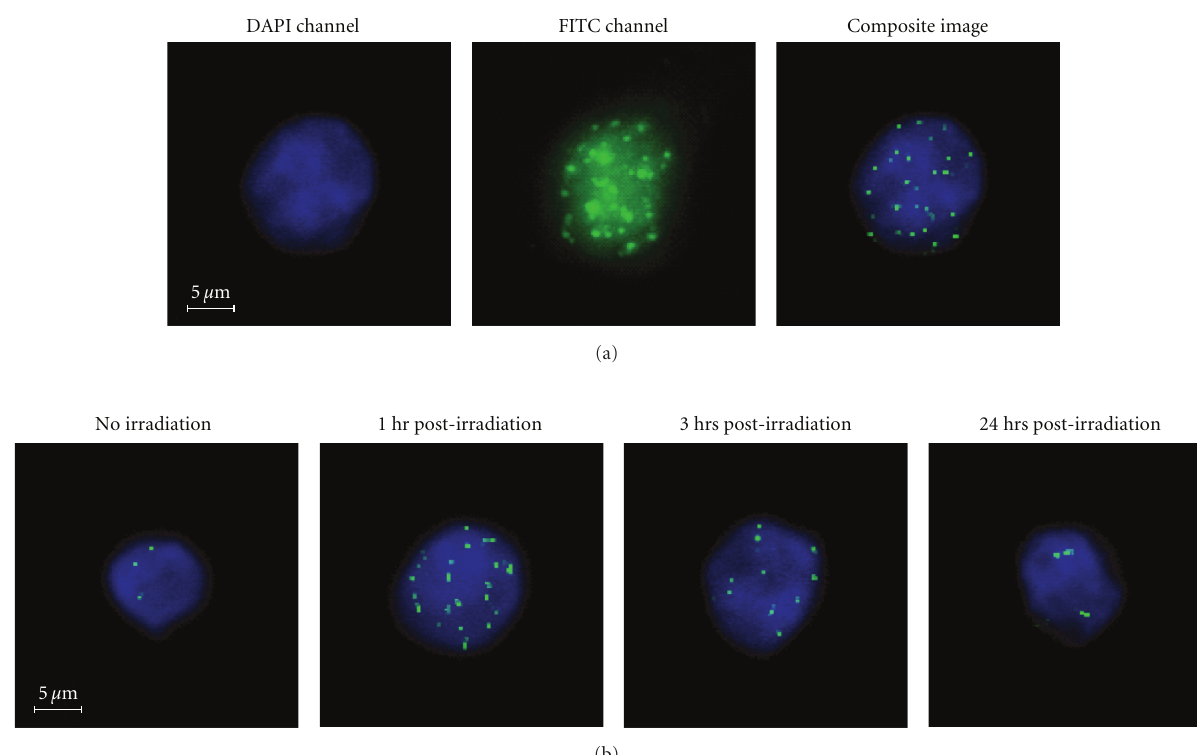
Figure 1: (a)Representative cell irradiated with 1.5Gy and incubated for 1 hour following exposure. Left panel: unadjusted, noncompressed image viewed under the DAPI channel; middle panel: unadjusted, noncompressed image viewed under the FITC channel; right panel: adjusted, composite image. The composite image underwent a series of image processing operations including the use of nonlinear algorithms and application of a counterstain mask. (b) Each of the four panels in this image displays a di ff erent, representative cell from each time point in sequence from left to right: preexposure, 1 hour, 3 hours, and 24 hours after 1.5 Gy gamma irradiation. All represent adjusted composite